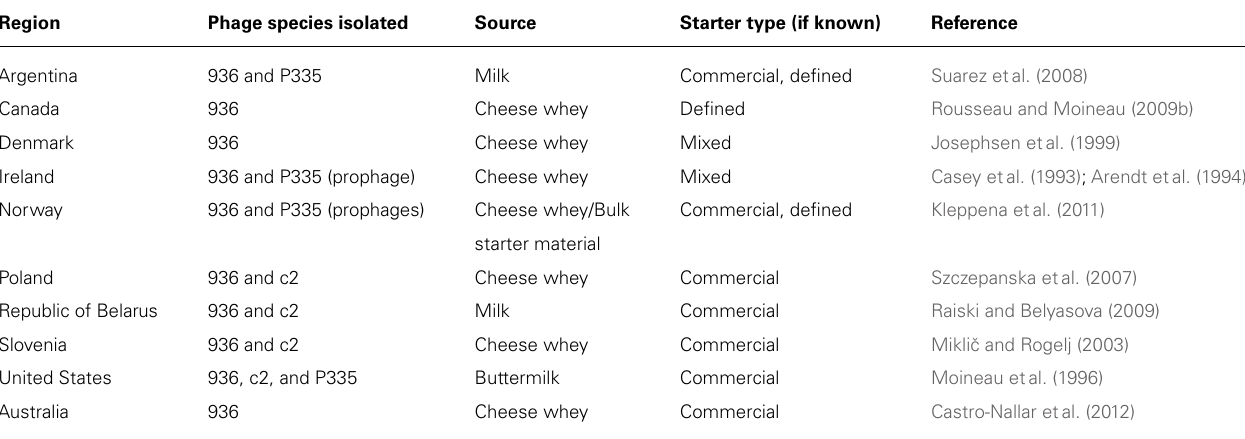
Table 1 | Isolation of dairy phages from different geographical locations